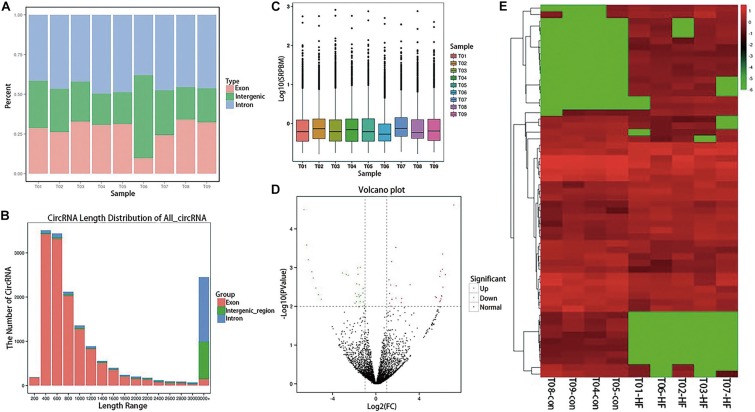
Expression profiling of circRNAs in patients with HF. (A) A histogram of read distributions in different regions of the genome. Each column represents a sample, and the height of the region represents the percentage of all mapped reads mapping to that region. (B) CircRNA length-distribution map. The horizontal coordinate represents the length interval of circRNA. The ordinate represents the number of circRNAs in the length interval. (C) SRPBM boxplot of each sample. The expression of circRNA in each sample was counted and normalized by SRPBM algorithm. In the figure, the abscissa represents different samples, and the ordinate represents the logarithm value of normalized sample expression quantity (D) Differential-expression volcano diagram. Each point in the differential-expression volcano diagram represents a circRNA, and the abscissa represents the log value of the differential multiple of a certain circRNA in the two samples. The y-coordinate represents the negative log of the p-value. In the figure, the green data points represent down-regulated differentially expressed circRNAs, the red data points represent up-regulated differentially expressed circRNA, and the black data points represent non-differentially expressed circRNAs. (E) CircRNA cluster heatmap with differential expression. The abscissa represents the sample name and the clustering result for each sample, whereas the ordinate represents different circRNAs and the clustering results for the circRNAs. The different columns in the figure represent different samples, and the different rows represent different circRNAs. The color represents the log10 of the circRNA-expression level in each sample.